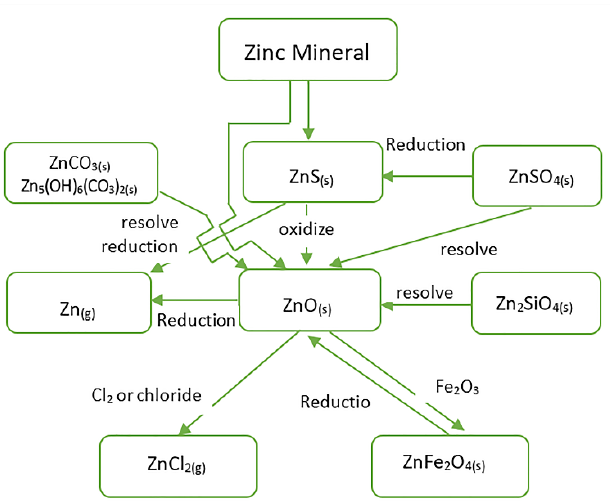
Figure 7. Migration and enrichment changes during the reduction of Zn-bearing minerals.